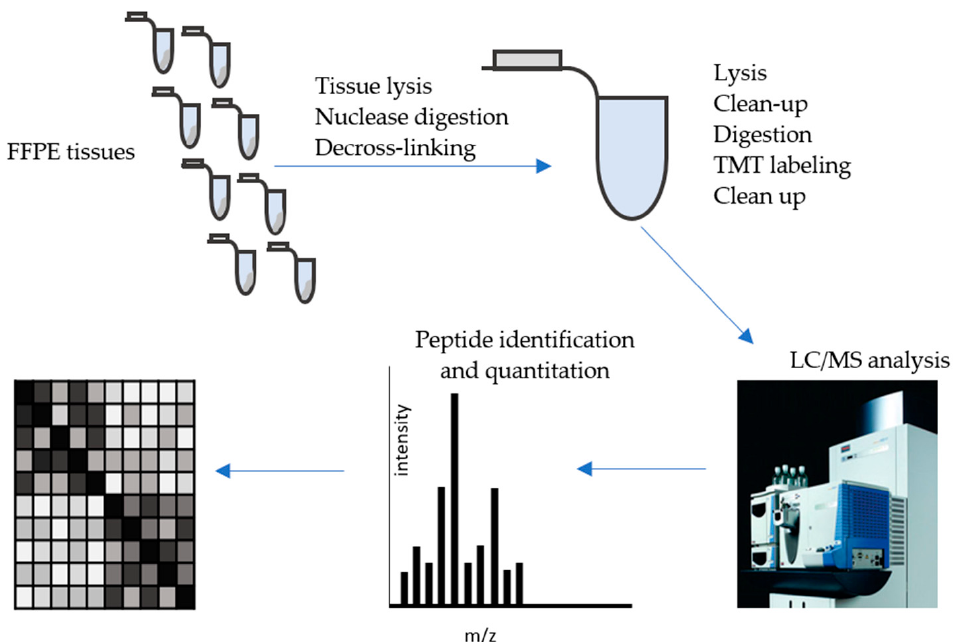
Figure 2. Proteomic analysis of formalin-fixed paraffin-embedded (FFPE) tissue sections using Single-Pot Solid-Phased-enhanced Sample Preparation Clinical Tissue Proteomics (SP3-CTP). In the SP3-CTP method, FFPE tissue sections are lysed, digested with nuclease and the proteins decross-linked. The protein lysate is then digested into peptides, which go through a series of clean up steps along with tandem mass tag (TMT) labeling to generate quantifiable peptides. The peptide lysate is analyzed using LC/MS and the relative abundance of peptides in comparative samples measured. The various tissue samples are segregated based on the relative abundance of a select percentage (e.g., 25%) of proteins that showed the greatest differences in abundance between the